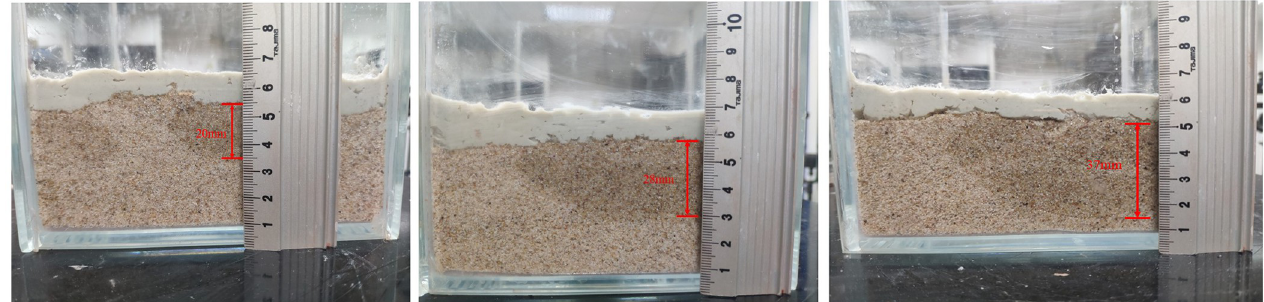
Fig 22. Infiltration of 11 mm thick bentonite films after dropping water. (A) Water dropped on an 11 mm thick bentonite film for 3 min; (B) Water dropped on an 11 mm thick bentonite film for 6 min; (C) Water dropped on an 11 mm thick bentonite film for 6